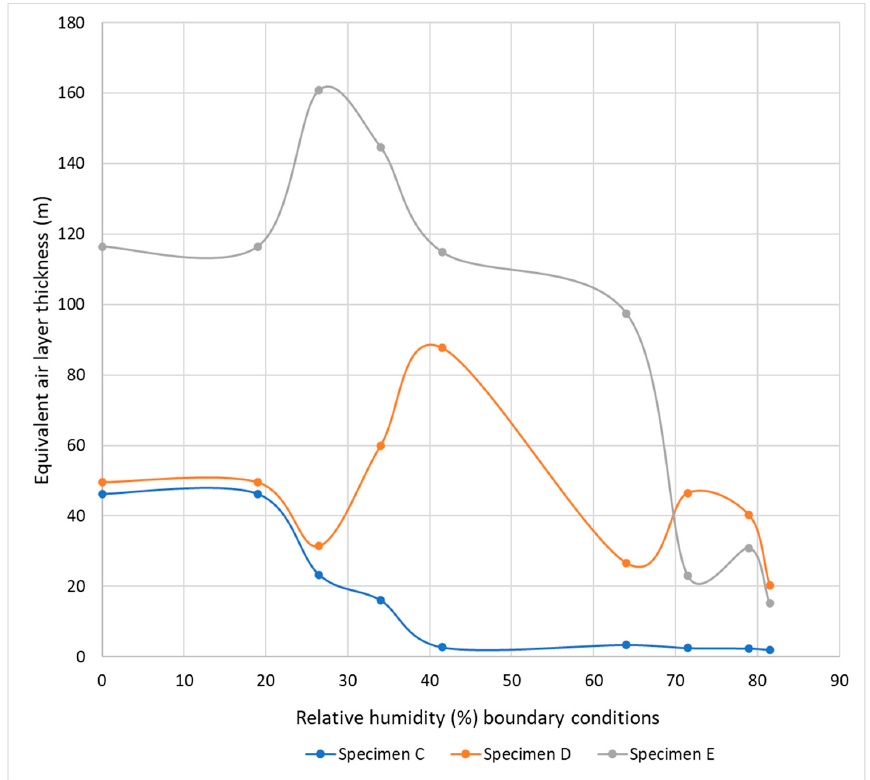
Figure 2. Plot of equivalent air layer thickness against relative humidity prior to harmonic curve adjustment for the three specimens.